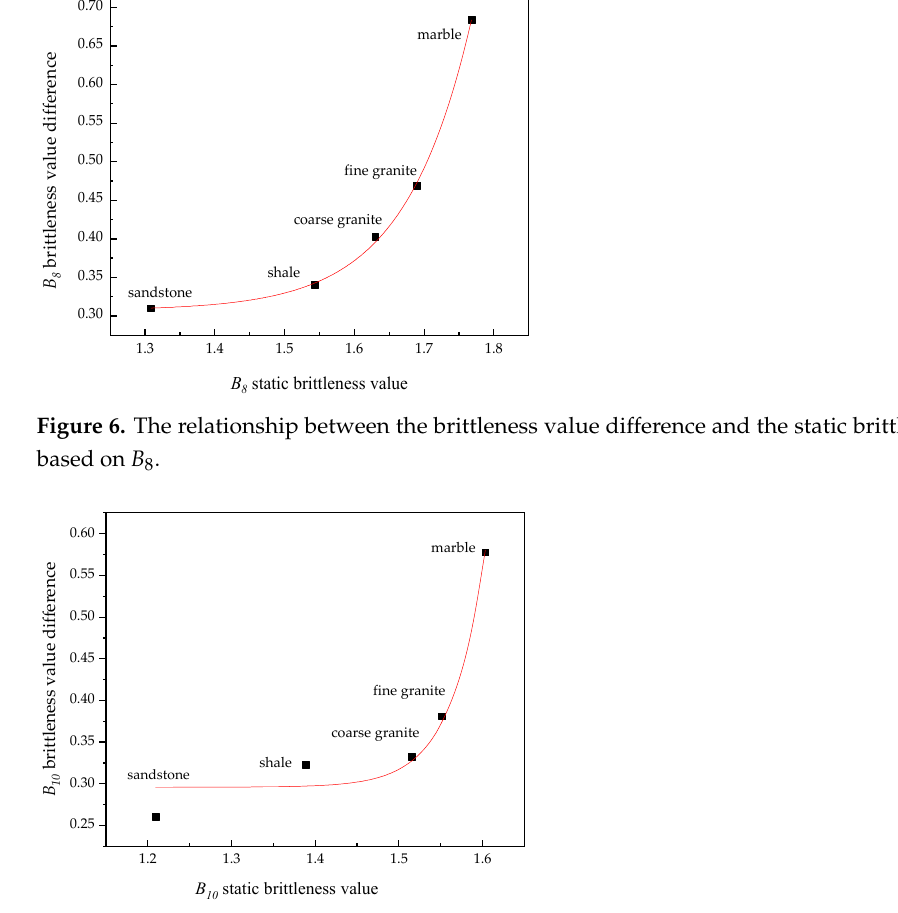
Figure 7. The relationship between the brittleness value difference and the static brittleness value based on B 10 .